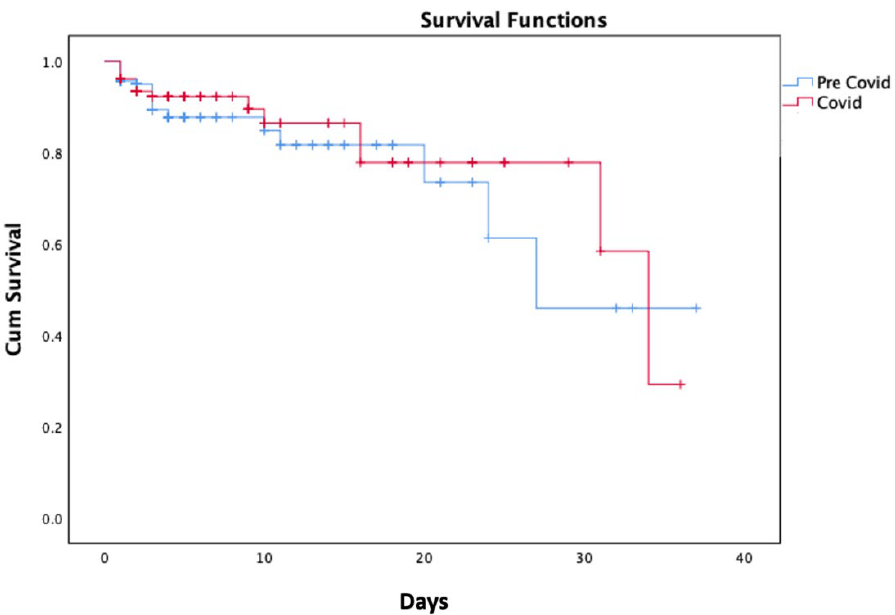
Figure 4. The Kaplan–Meir survival curves for in-hospital mortality between the pre-COVID-19 outbreak period and the COVID-19 outbreak period. Table 2. Multivariable analysis for in-hospital mortality of STEMI patients during the COVID-19